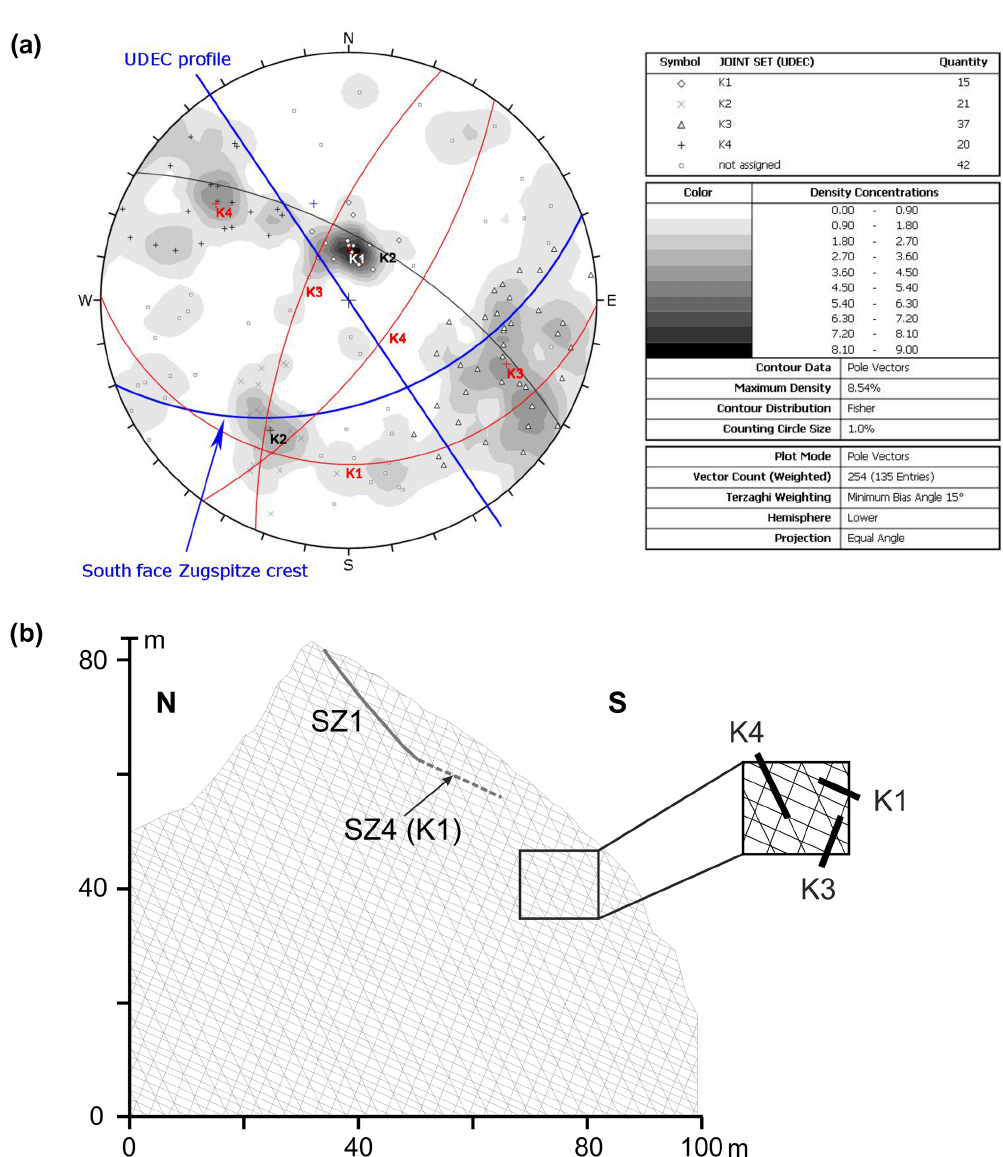
Figure 3. (a) Orientations of field-measured discontinuities in a stereographic projection, calculated with Dips 7.0 (Rocscience). Great circles with red labels represent the joint sets (K) implemented in the numerical model. Contours depict the Fisher concentrations (density) of the poles. (b) Fracture network, extent and topography of the 2D numerical model. Shear zones (SZs) included in the model are marked with thick grey lines. The dashed line represents the assumed prolongation of the potential failure plane in the lower slope sections.